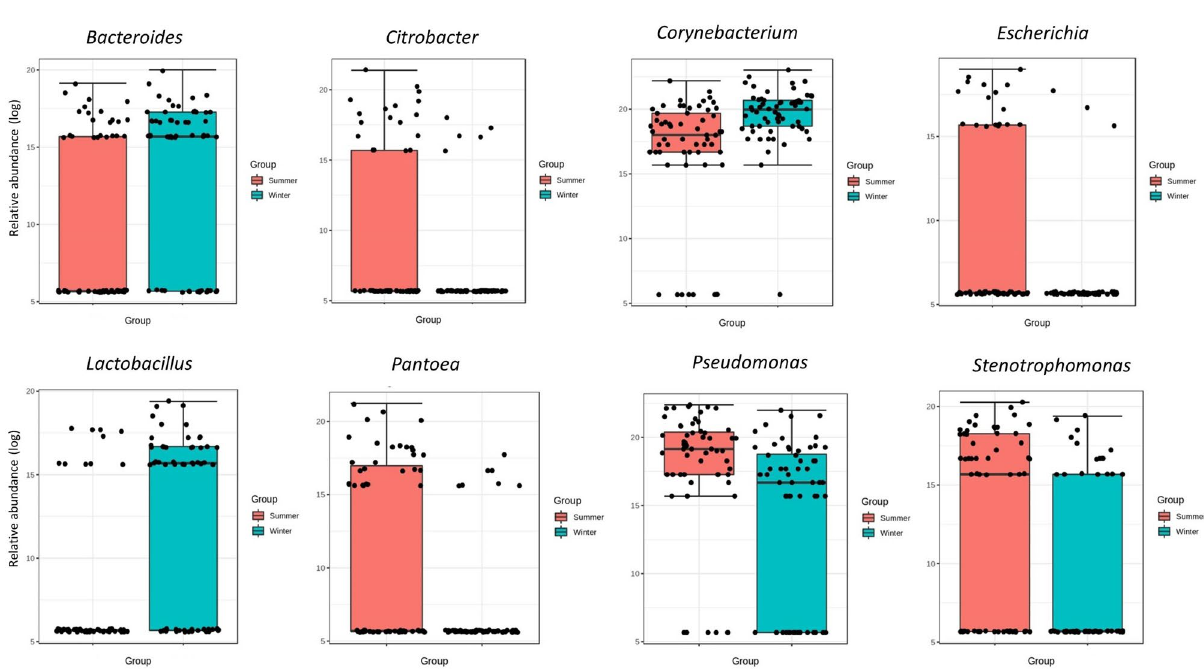
Figure 5. Linear discriminant analysis Effect Size (LEfSe) at genus level between the summer and winter. An LDA score greater than 2 was used to determine significantly different genera between the